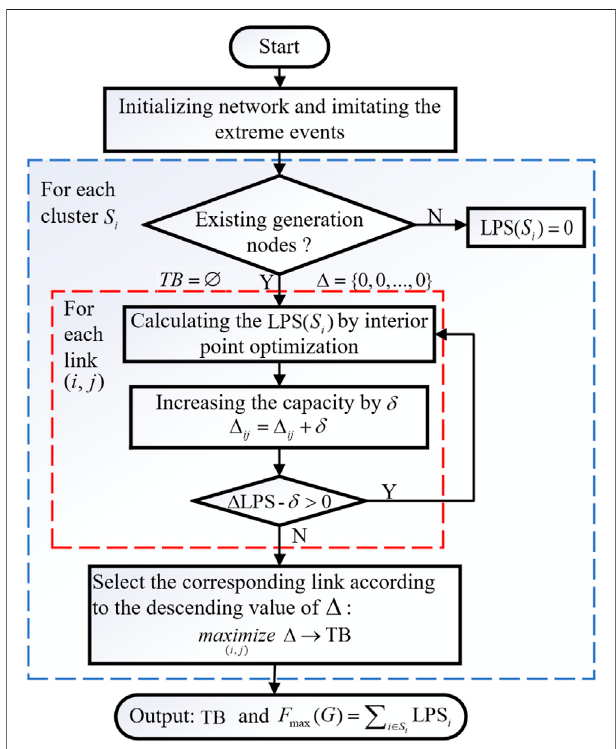
FIGURE 6 | The fl owchart of the iterative greedy search scheme, which includes the interior point optimization and bottleneck identi fi cation algorithm.